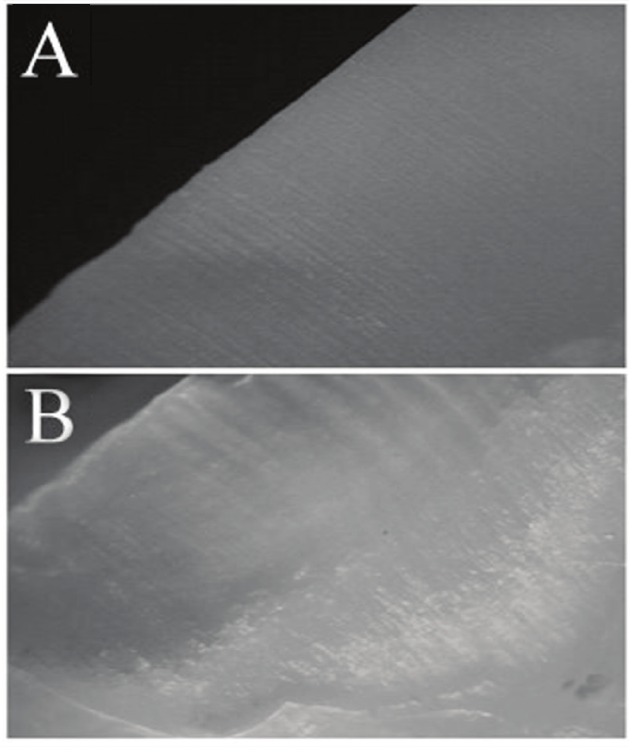
Fig.1. Adhesive Failure (A), Mixed Failure